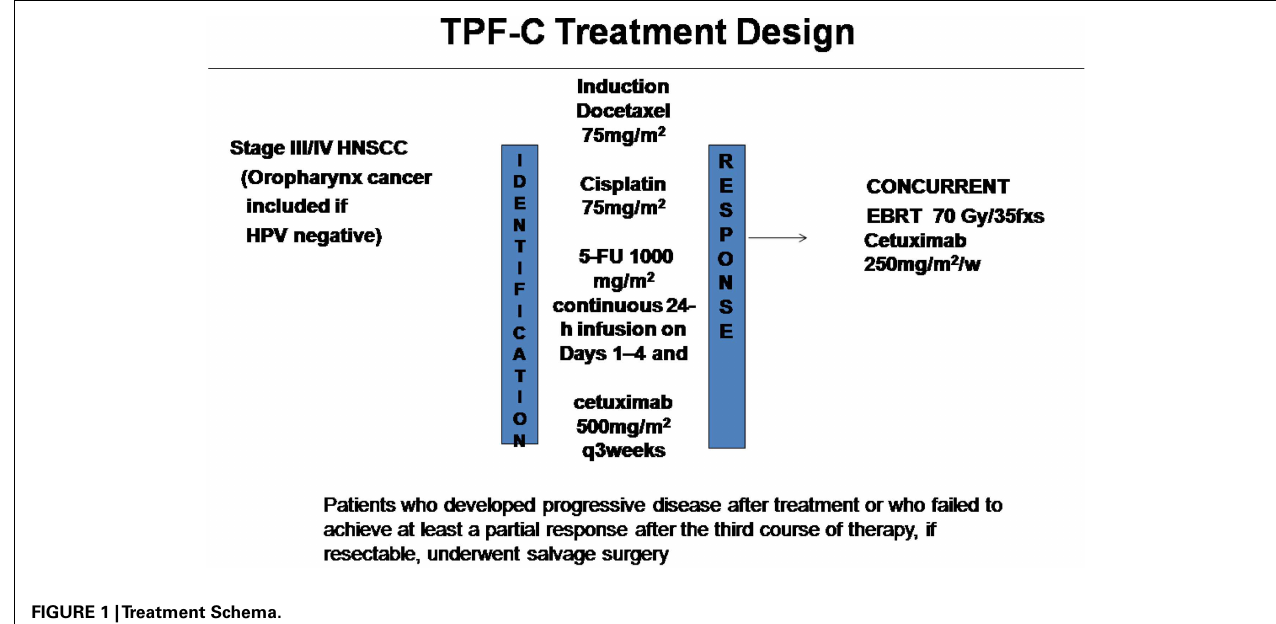
FIGURE 1 |Treatment